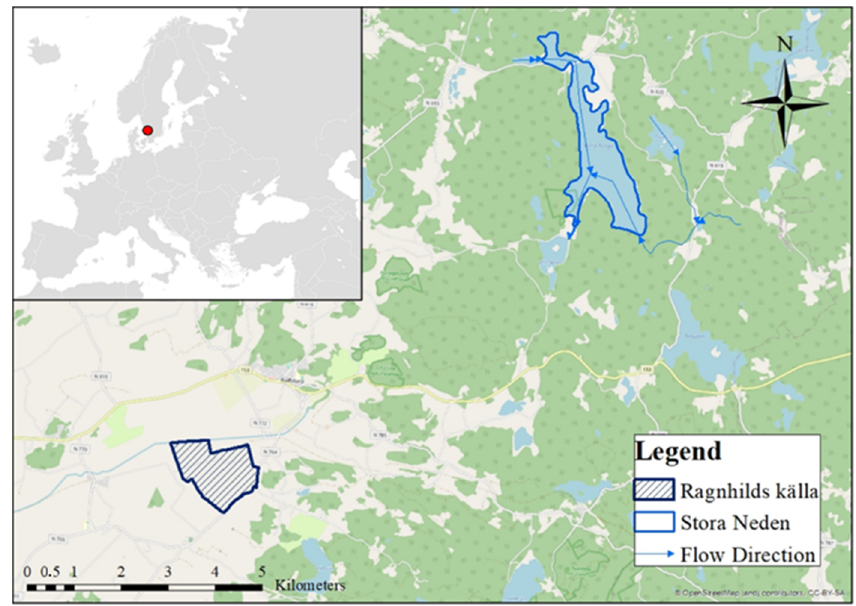
Figure 1. Map over Kvarnagården DWTP’s raw water sources; the lake Stora Neden and the aquifer Ragnhilds källa.